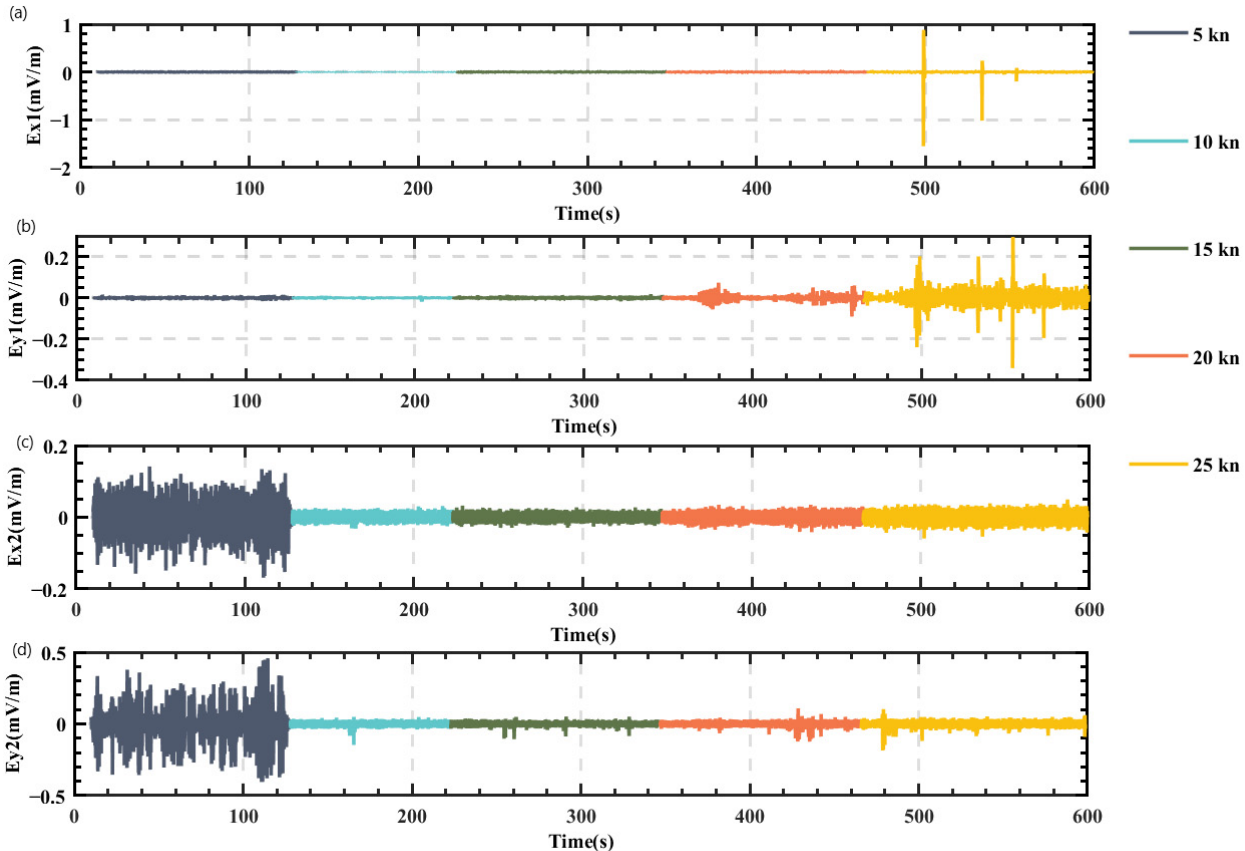
Figure 5. Time domain diagram of noise interference test caused by different platform velocity. ( a ) Longitudinal component of the bow sensor; ( b ) transverse component of the bow sensor; ( c ) longitudinal component of the stern sensor; ( d ) transverse component of the stern sensor.